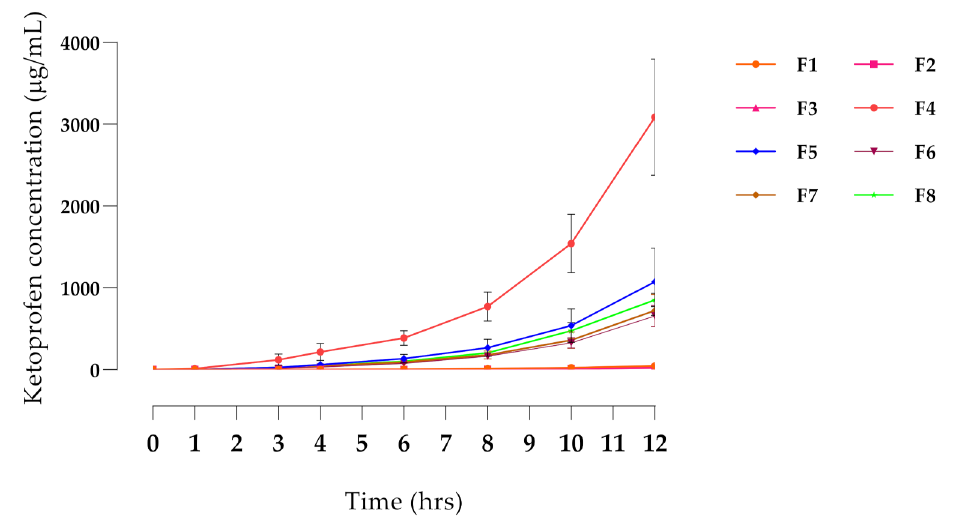
Figure 1. In vitro permeation profile of ketoprofen through excised dog skin. Formulations (F1–F8) were investigated in terms of penetration of the active drug. Each data point represents an average value of sample concentration from three replicates ( n =